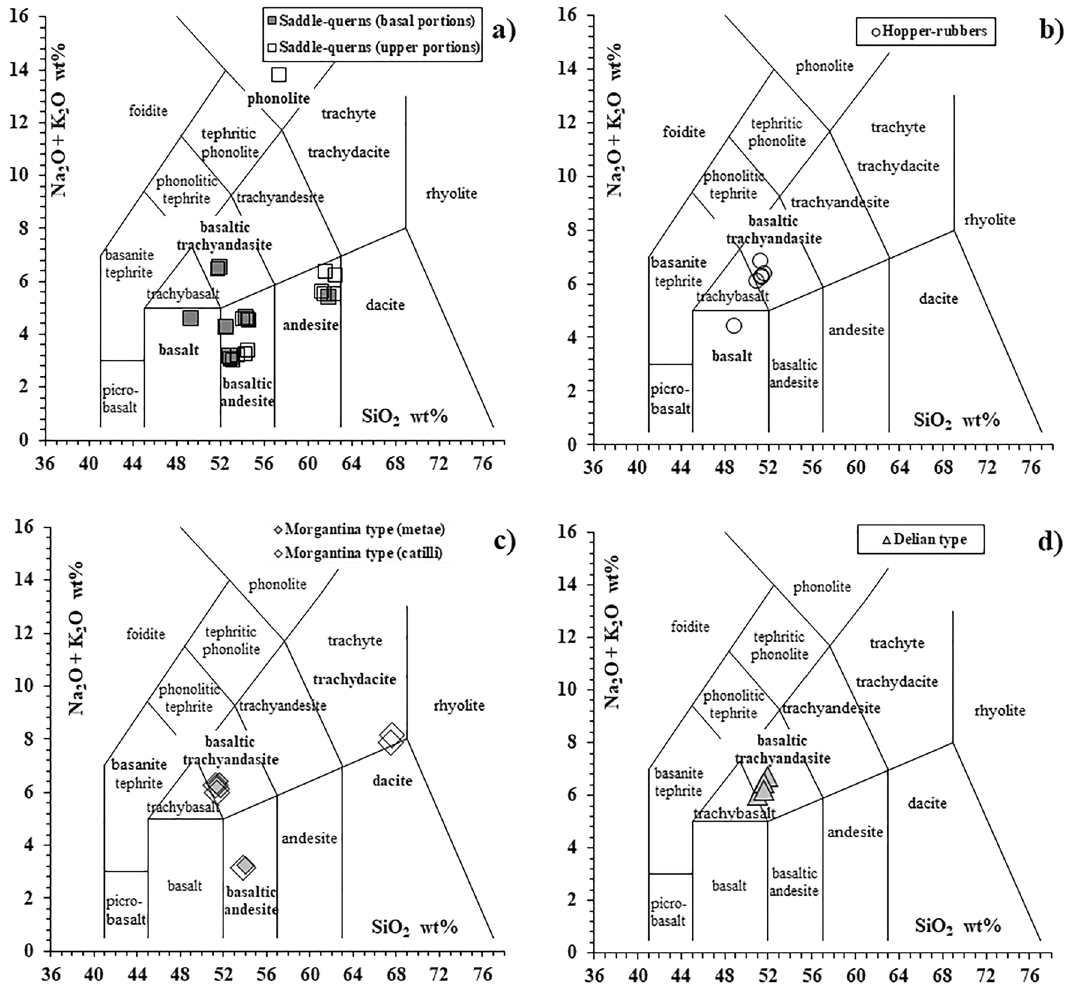
Figure 2. The Total Alkali-Silica classification diagram for volcanic rocks 27 ; ( a ) saddle-querns; ( b ) rectangular hopper-rubbers; ( c ) rotary Morgantina-type; ( d )